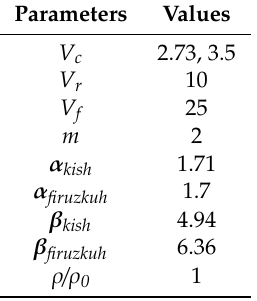
Table 2. Objective function parameters for the annual energy production